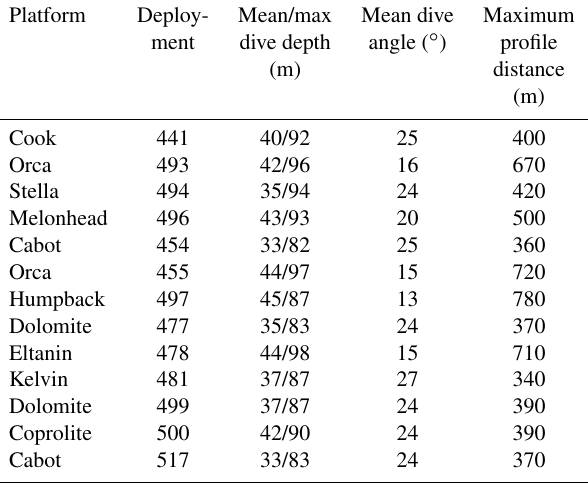
Table 2. Glider dive specifics per mission. The maximum profile distance is calculated from the maximum dive depth and mean dive angle and gives the maximum horizontal extent of a single dive (both down and up